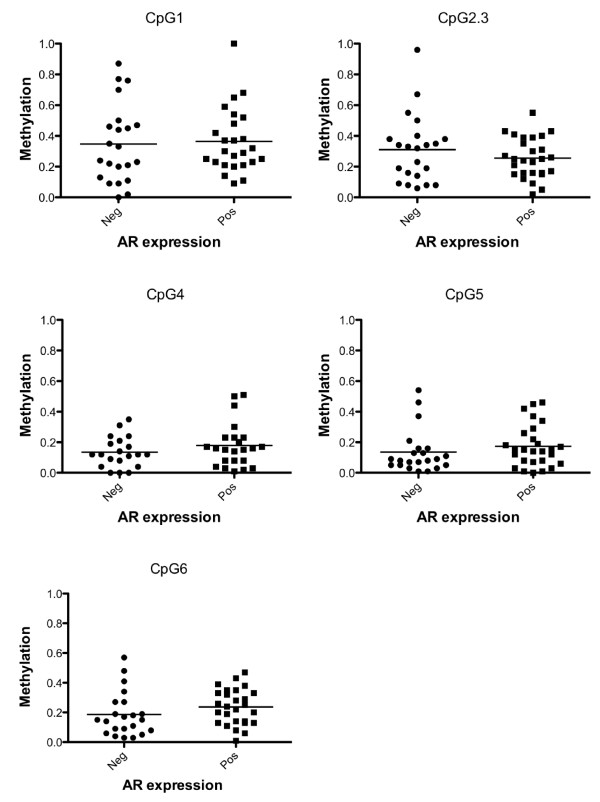
DNA methylation of an 115 bp region in the AR promoter is not associated with loss of AR protein expression in a selective group of primary breast tumours. Methylation of six CpG dinucleotides in the AR promoter of AR positive (Pos) and negative (Neg) Grade III breast tumours as determined by Sequenom MassARRAY (Region 4, Figure 1). Due to cleavage patterns, the average methylation was determined for CpG dinucleotides 2 and 3. Each dot represents an individual patient. A methylation value of 1.0 indicates a fully methylated amplicon, while a value of 0.0 indicates a fully unmethylated amplicon. Horizontal lines represent average cohort methylation.